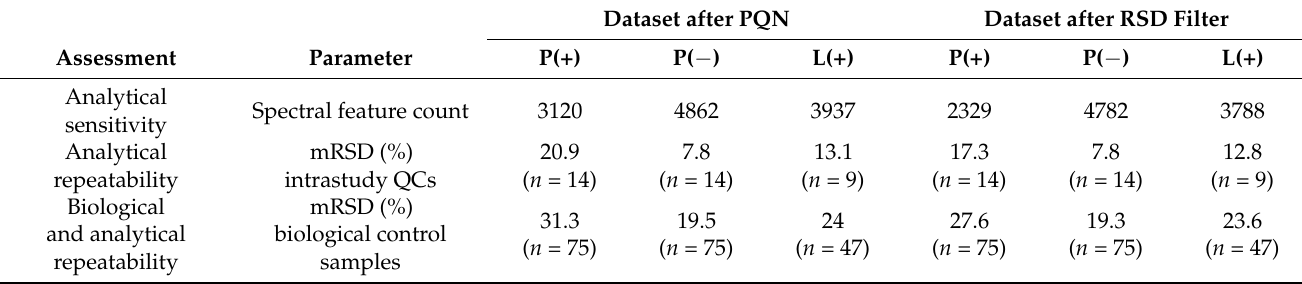
Table 1. Assessment of analytical sensitivity as well as analytical and biological repeatability of the automated in vitro metabolomics workflow across three nESI-DIMS assays. P(+), P( − ), L(+) corre- spond to polar positive, polar negative and lipid positive nESI-DIMS assays. For the measurement of repeatability, the number of replicates is given in brackets below the mRSD